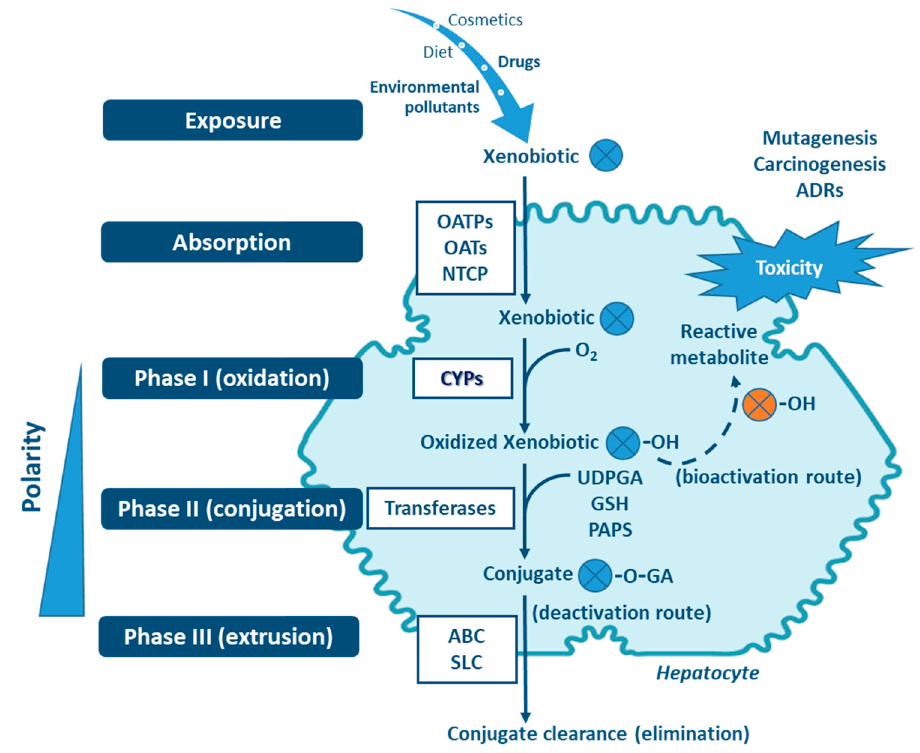
Figure 1. Xenobiotic metabolism in the hepatocyte and the central role of CYPs in biotransformation. Besides hydroxylation, exemplified here, CYPs catalyze a variety of other biotransformation reactions (e.g., epoxidation, dealkylation, oxygenation, dehydrogenation, dehalogenation, among others). Non-CYP mediated metabolism may also occur in Phase I via flavin-containing monooxygenases (FMOs), NAD(P)H:quinone oxidoreductases (NQOs), amine oxidases, alcohol dehydrogenases, esterases and peroxidases. ABC: ATP binding cassette (e.g., multidrug resistance protein family—MRP); GA: glucuronic